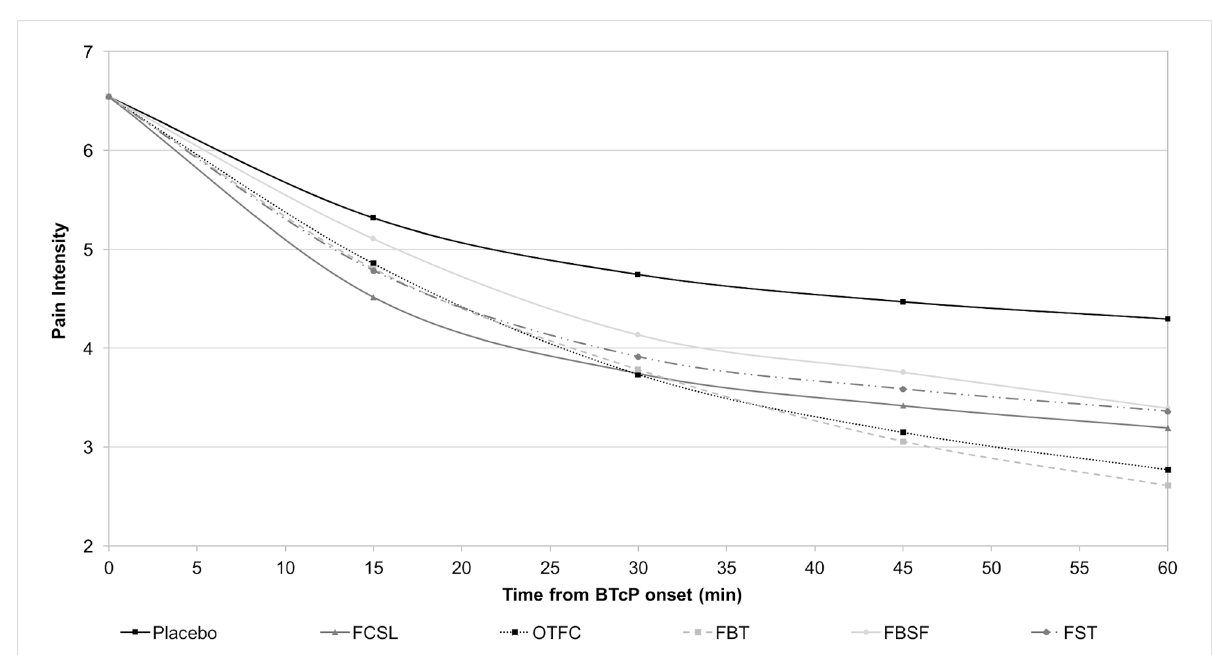
Fig 1. PI curves during a BTcP, derived from trials data. FCSL = SublingualFentanyl Citrate; OTFC = Oral Transmucosal Fentanyl Citrate; FBT = Fentanyl Buccal Tablet; FBSF = Fentanyl Buccal SolubleFilm; FST = Fentanyl SublingualTablets.